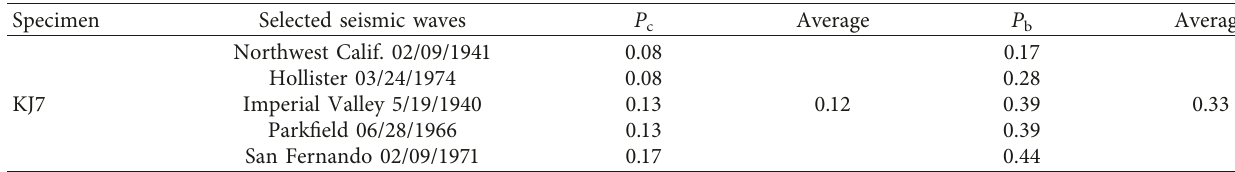
Table 19: Plastic hinge rates of beams and columns in model KJ7.